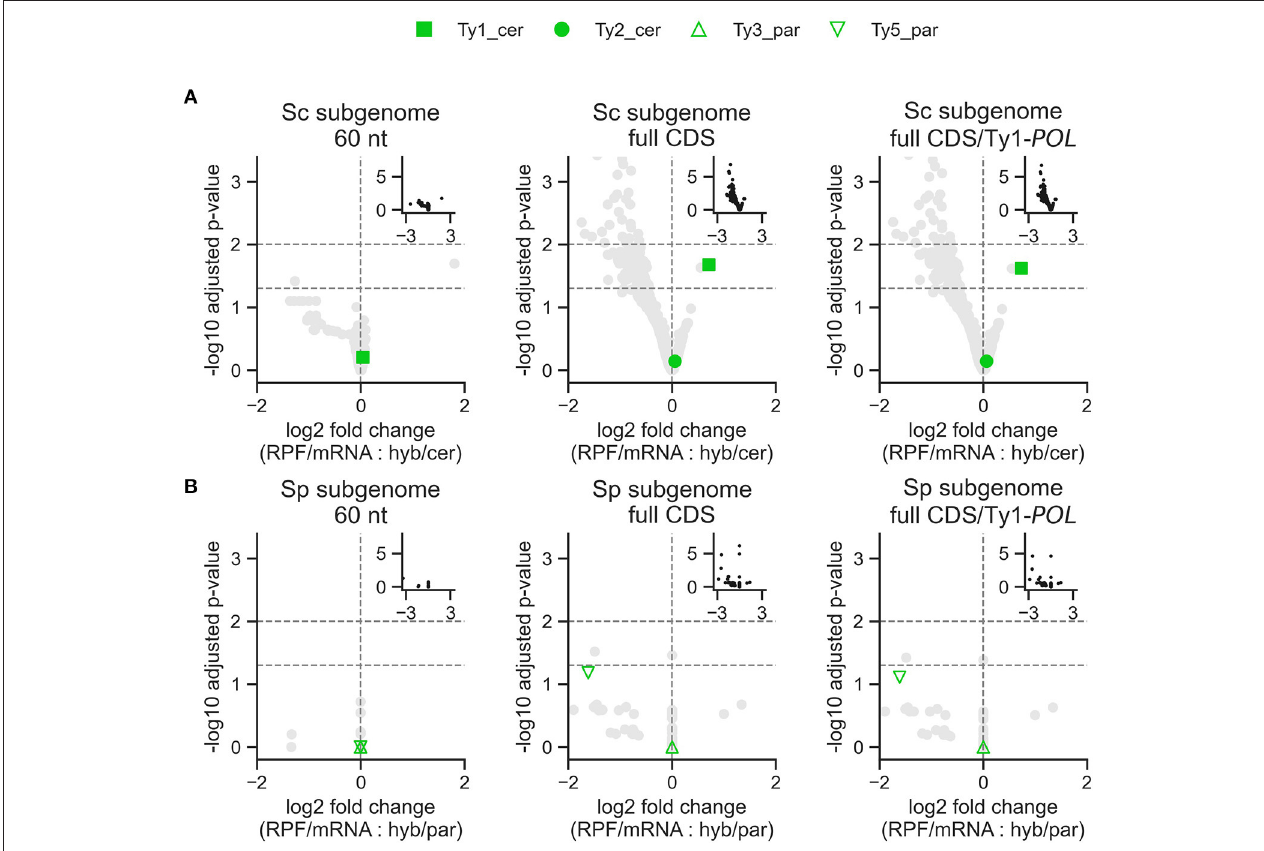
FIGURE 6 | Differential expression analysis of Ty translation efficiency in S. cerevisiae x S. paradoxus hybrids from DS3. Log 2 fold change is shown for the two interaction terms in the model: RNA-seq experiment (RPF vs. total mRNA) with the difference between the hybrid and the S. cerevisiae (A) or S. paradoxus (B) parent. Positive log 2 fold change values represent higher translation efficiency in the hybrid compared to the parental species. Insets show the complete data. Ty3_cer and Ty4_cer are absent from the graphs because no p -values could be